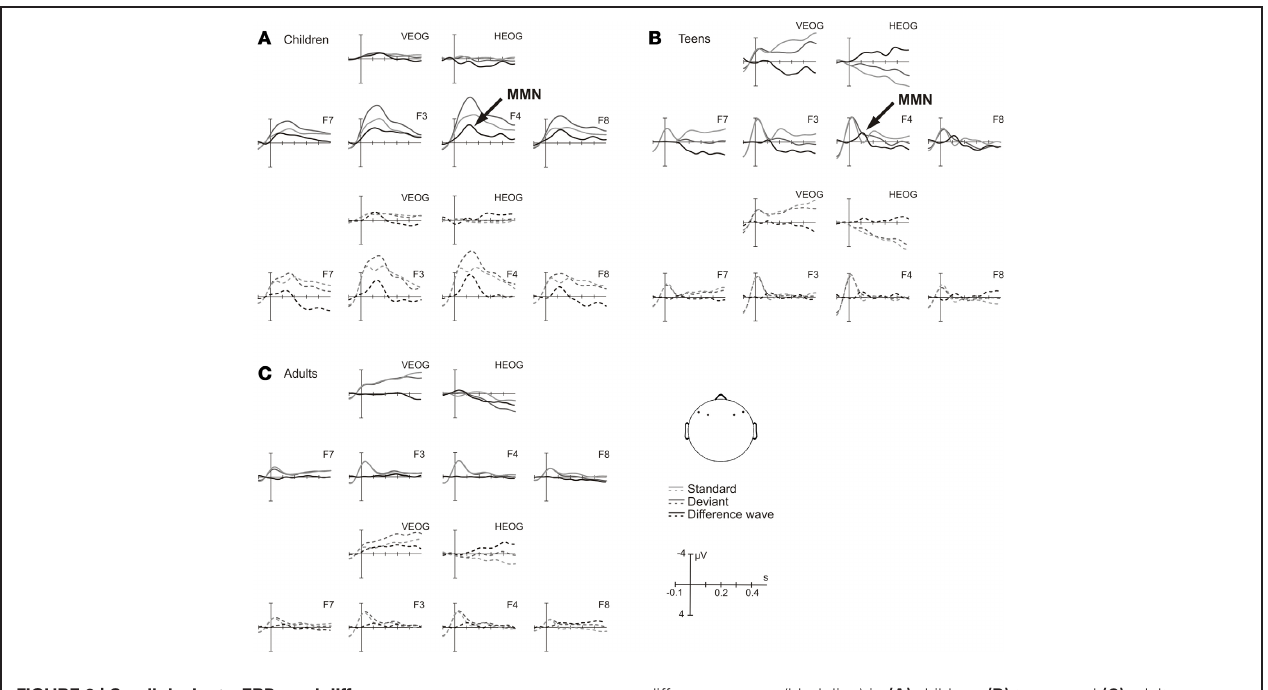
FIGURE 3 | Small deviant—ERPs and difference waves. Event-related potentials elicited by the ITD off signal used as deviant (dark gray line) and as standard (light gray line) as well as the respective